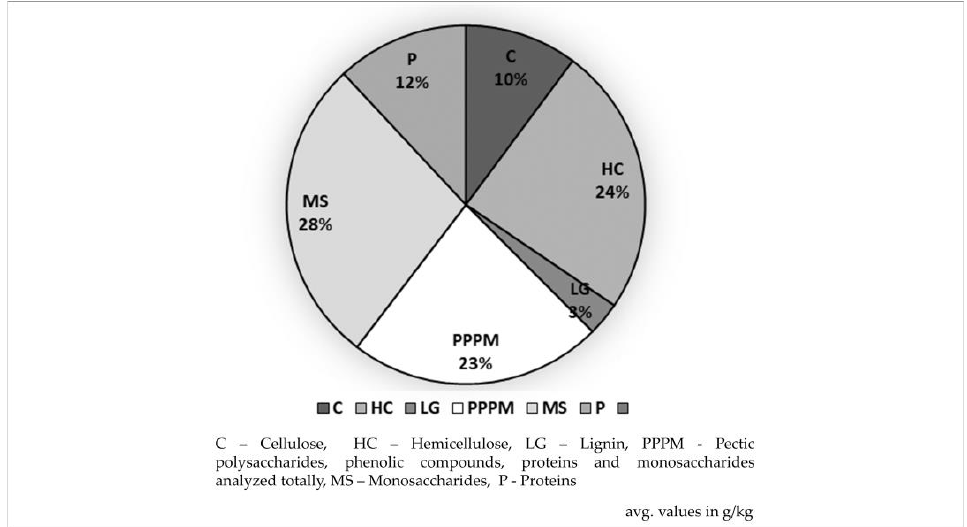
Figure 1. The composition of LB used in the experiment.